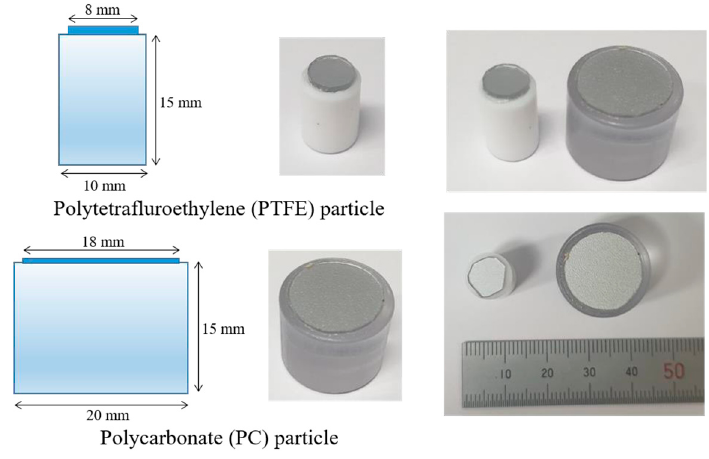
Figure 1. Cylindrical model particles with photoelastic sheets.